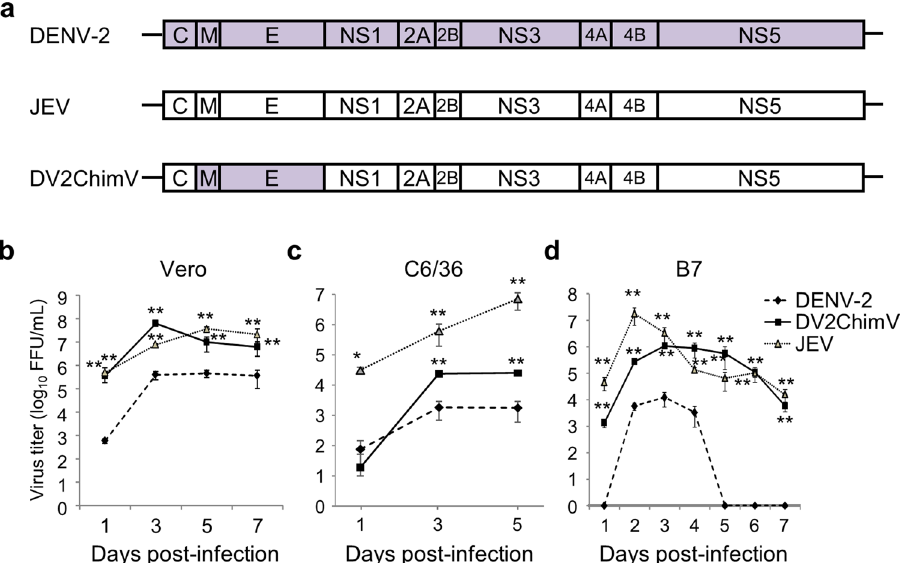
Figure 1. Virus replication in vitro. ( a ) Schematic representation of DENV-2, JEV, and DV2ChimV genomes. ( b – d ) Replication of DENV-2, JEV, and DV2ChimV. Mammalian Vero cells, insect C6/36 cells, and mouse B7 cells were infected with DENV-2, JEV, or DV2ChimV. Each cell type was infected at a different multiplicity-of- infection (MOI; 0.01 for Vero and C6/36 cells, 0.2 for B7 cells). Culture media were collected at the indicated time points post-infection. Viral titers were determined by focus-forming assays and expressed as the logarithm of focus-forming units (FFU) per milliliter. Results are expressed as mean + SD of triplicate experiments. Viral titers of each day were analyzed by one-way ANOVA after log transformation. Significance of the levels was assessed by the Dunnett’s Multiple Comparison Test by using viral titer of R05-624 as a control. Statistical differences in viral titers were calculated relative to that of R05-624. * p < 0.01, ** p <